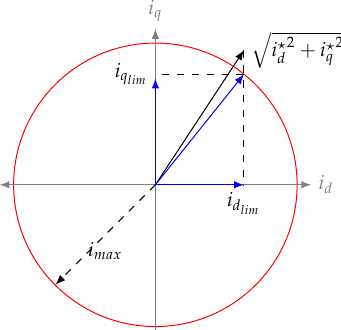
Figure 3. Priority given to i d